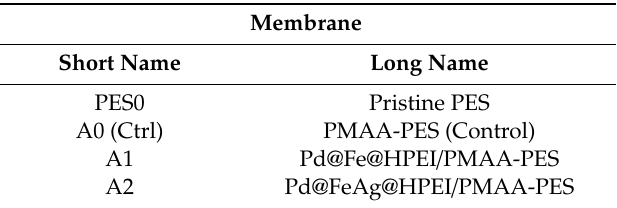
Table 1. Designations for the